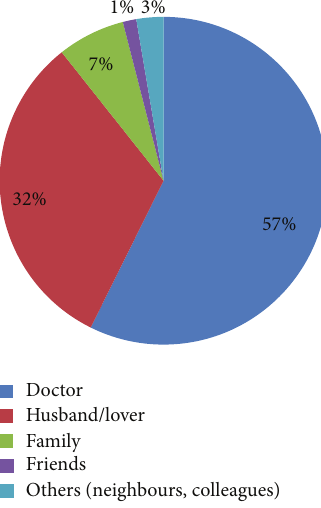
Figure3:Peoplewhoinformedrespondents’decisionstogettreated ( 𝑁 = 75